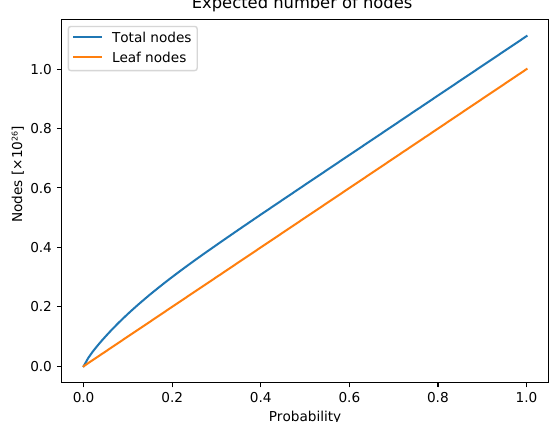
Figure 2. Size of a tree ( E ( |M| ) ) compared to the number of stored sets ( E ( | M | ) ), as the probability parameter p increases. Parameters σ and n are 26 and 10, respectively. The additional overhead space that our data structure uses does not increase as the tree is becoming more and more